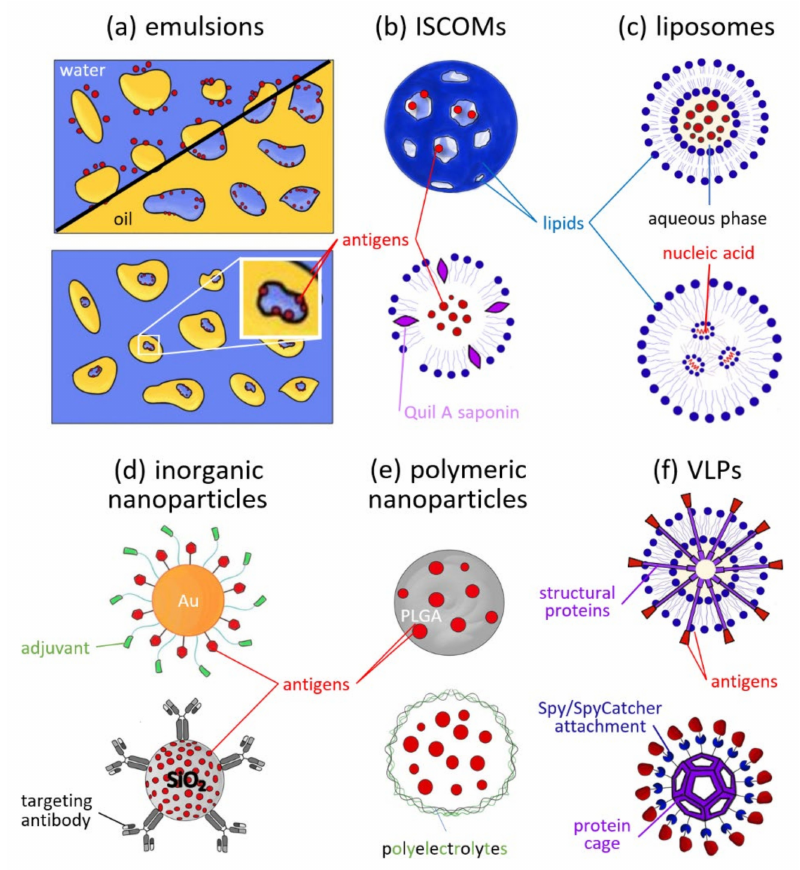
Figure 2. Types of nanoparticles used in vaccines. The images are schematic and do not depict the size relationships of the particles to their components. ( a ) Oil-in-water (top left), water-in-oil (top right), and water-in-oil-in-water emulsion (bottom, with reverse micelle enlarged). The antigen is usually adsorbed to the phase interface that is stabilized by the emulsifier (not shown). ( b ) Three- dimensional view (top) and cross-section schematic (bottom) of an ISCOM. ( c ) Liposome with protein antigens in the aqueous center (top) and with nucleic acids complexed to cationic lipids inside (bottom). ( d ) Gold nanoparticles decorated with antigen and adjuvants (top) and mesoporous silica nanoparticle functionalized with antibodies for targeting (bottom). ( e ) Isotropic PLGA nanoparticle (top) and layer-by-layer polyelectrolyte microcapsule (bottom). ( f ) Virus-like particles with (top) and without (bottom) enveloping